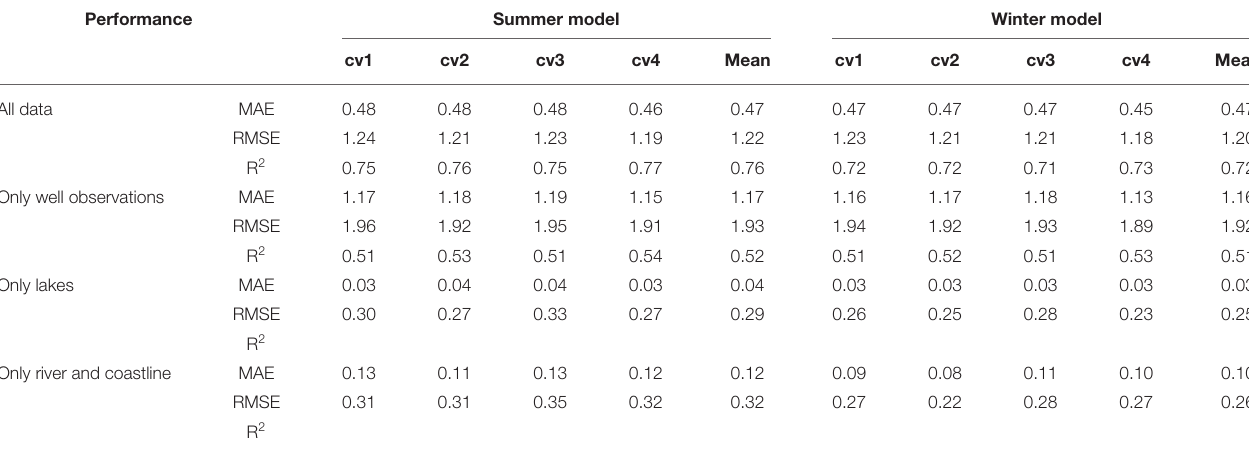
TABLE 4 | Results for a 4-fold cross validation (cv) applied on the summer and winter model. Performance